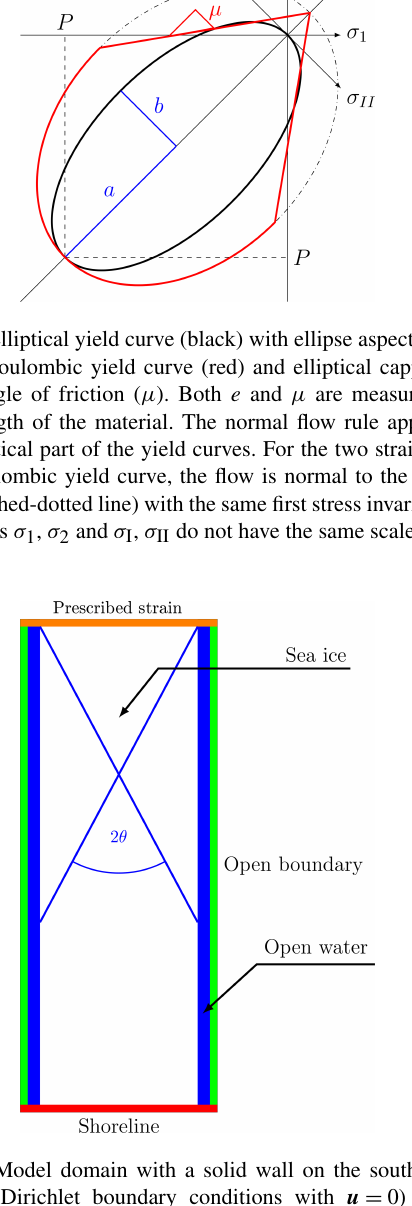
Table 1. Model parameters of the reference